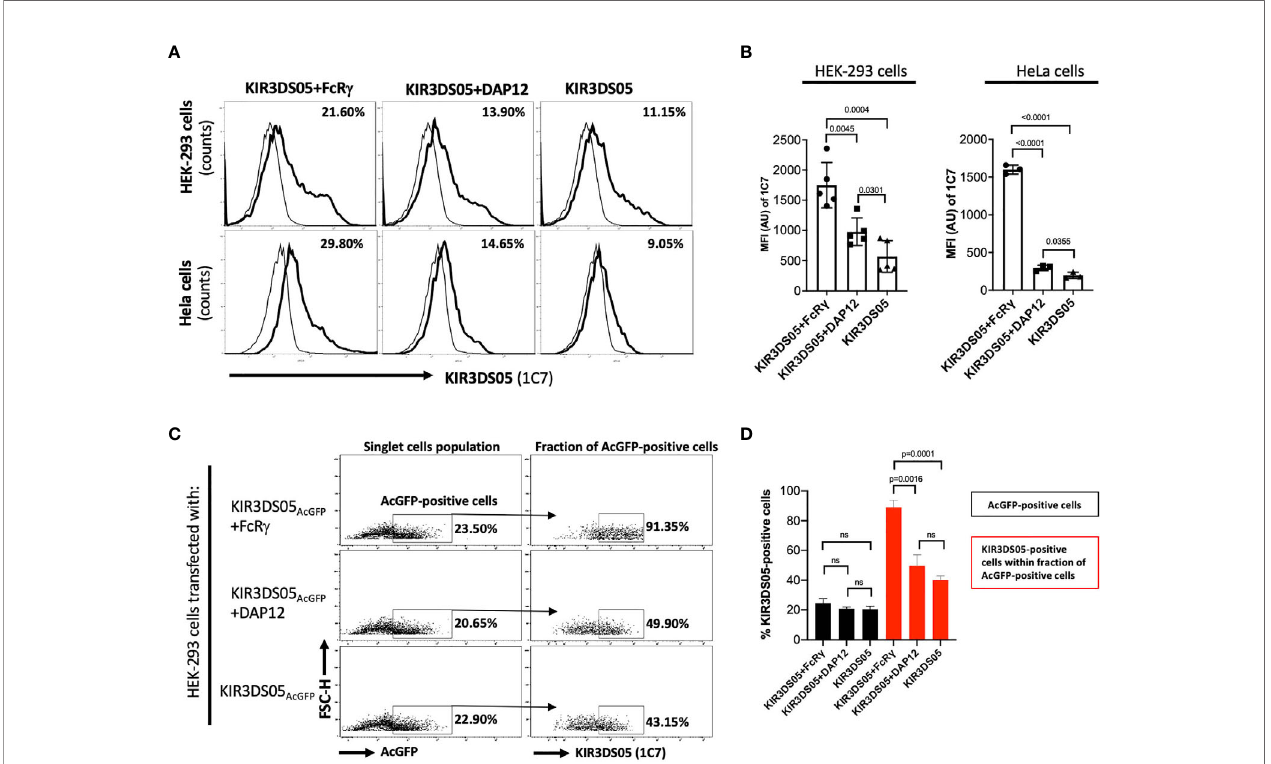
FIGURE 2 | Flow cytometry analysis of rhesus macaque KIR3DS05 cell surface expression in the presence of myc-tagged FcR g or DAP12 adaptor proteins. (A) Histograms of a representative experiment of HEK-293 and HeLa cells transiently transfected with AcGFP-tagged KIR3DS05, either alone or in combination with either DAP12 or FcR g (thick lines). Monoclonal anti-rhesus macaque KIR antibody 1C7 was used to detect KIR3DS05 expression indicated as percent positive cells. Untransfected HEK-293 and HeLa cells were used as respective negative controls of 1C7 staining (thin lines). (B) Mean fl uorescence intensity of KIR3DS05 expression in transfected cells among independently performed experiments (HEK-293 n=5; HeLa n=3). (C) HEK-293 cells after transfection with AcGFP-tagged KIR3DS05 were gated on the singlet cells and then 1C7-stained cells were measured within the fraction of AcGFP-positive cells population. A representative experiment is shown. (D) 1C7-stained cells within the AcGFP-positive fraction were measured in individual experiments (n=3). ns, statistically not signi fi